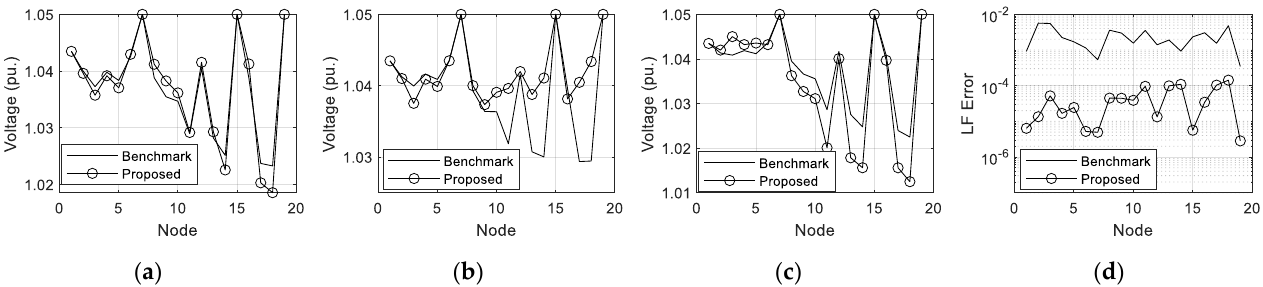
Figure 15. Comparison between benchmark and proposed methods at ( a ) Phase − AN, ( b ) Phase − BN, ( c ) Phase − CN, and ( d ) errors in LF results.